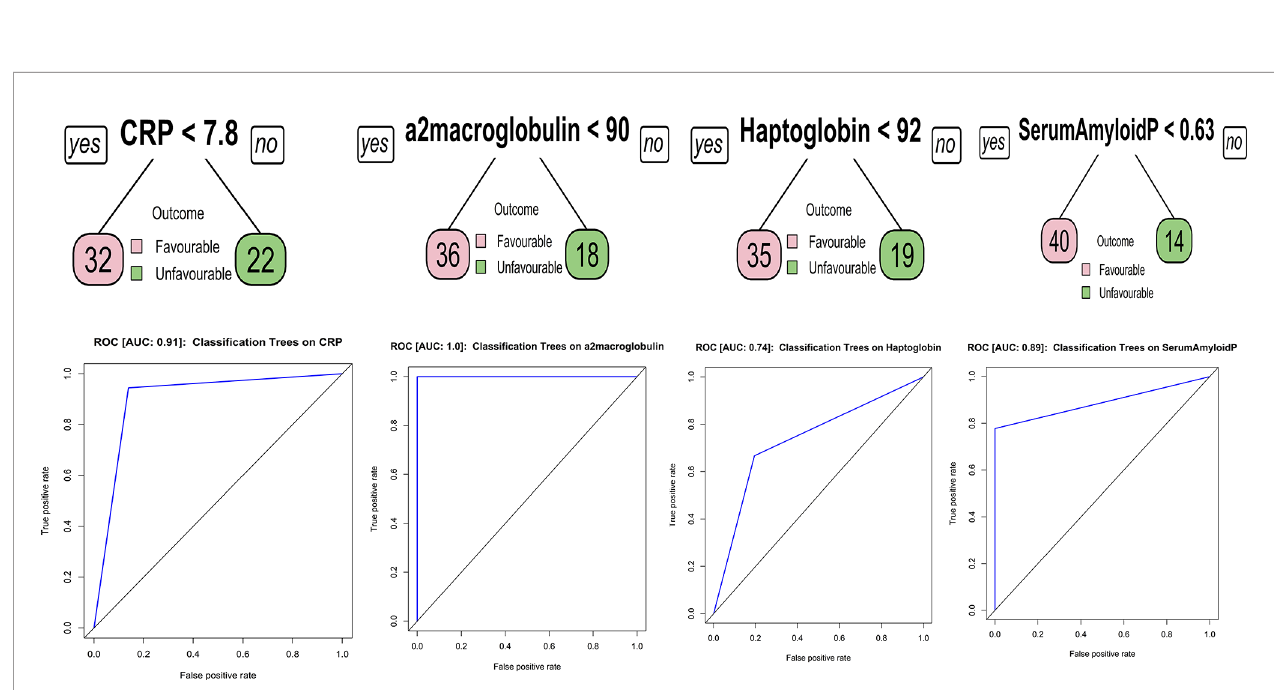
FIGURE 3 | Identi fi cation of biomarkers showing the strongest associations with active TB disease. CART model analysis shows the APPs that exhibited the highest accuracy in discriminating TB treatment failure from cure. Receiver operator characteristics curves were employed to quantify the accuracy of single